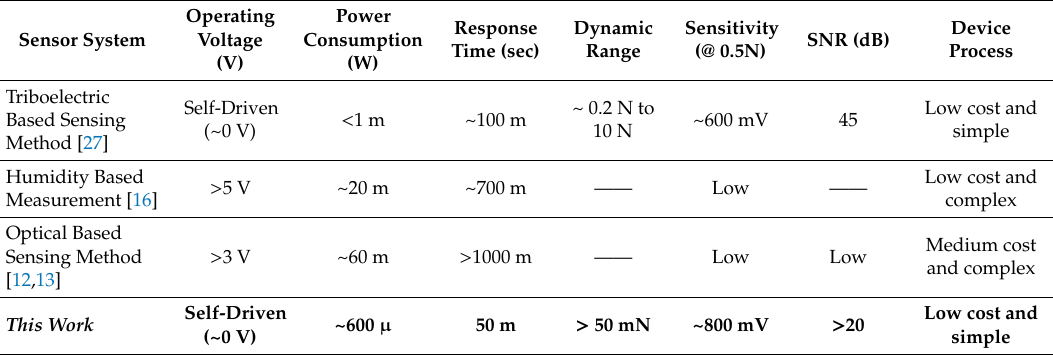
Table 1. Summary of this research compared with the prior arts in terms of sensitivity, signal-to-noise ratio (SNR), dynamic range, driving voltage, response time, and power